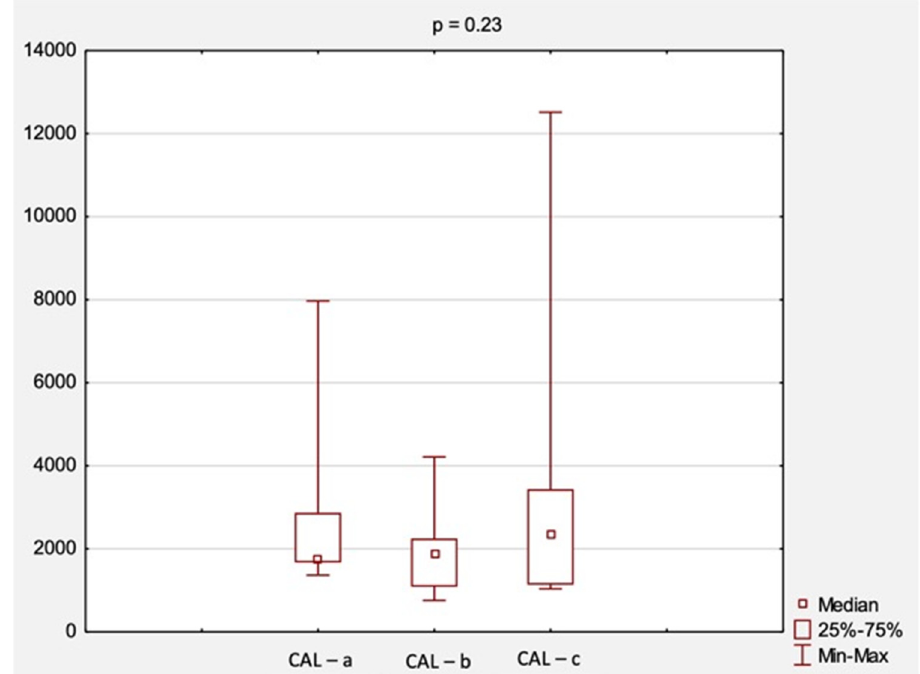
Figure 1. The comparison of CAL levels according to AAA diameter. Abbreviations: CAL, calprotectin; a, small aneurysm (<4.5 cm); b, medium aneurysm (4.5–5.5 cm); c, large aneurysm (>5.5 cm); AAA, abdominal aortic aneurysm; p , level of statistical significance.